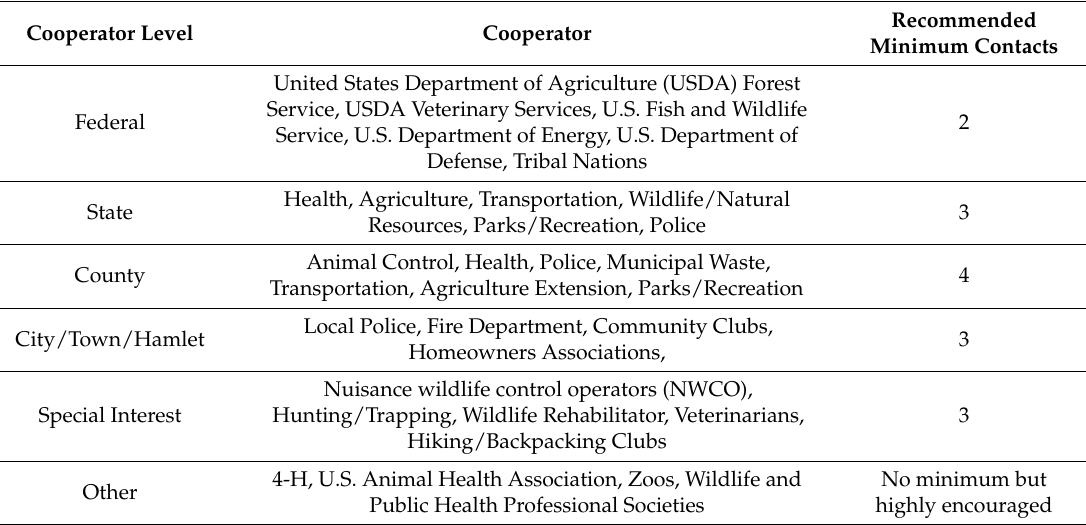
Table 1. Examples of expanded enhanced rabies surveillance cooperative network